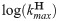
The heat maps showing the correlation between group size and the number of joined group of members.The color scale corresponds to the log-frequency of occurrence between the size of a group and (a) the largest number of group joined by an individual member in the group, and (b) the average number of group joined by the members in the group. The Pearson correlation coefficients for log(kmaxH) vs. log(s
H) and for log(⟨k
H⟩) vs. log(s
H) respectively are 0.77 and 0.59. The pink lines show the curves on their means along vertical values, and the blue dashed line in (a) shows the fitting power function with slope 0.54.